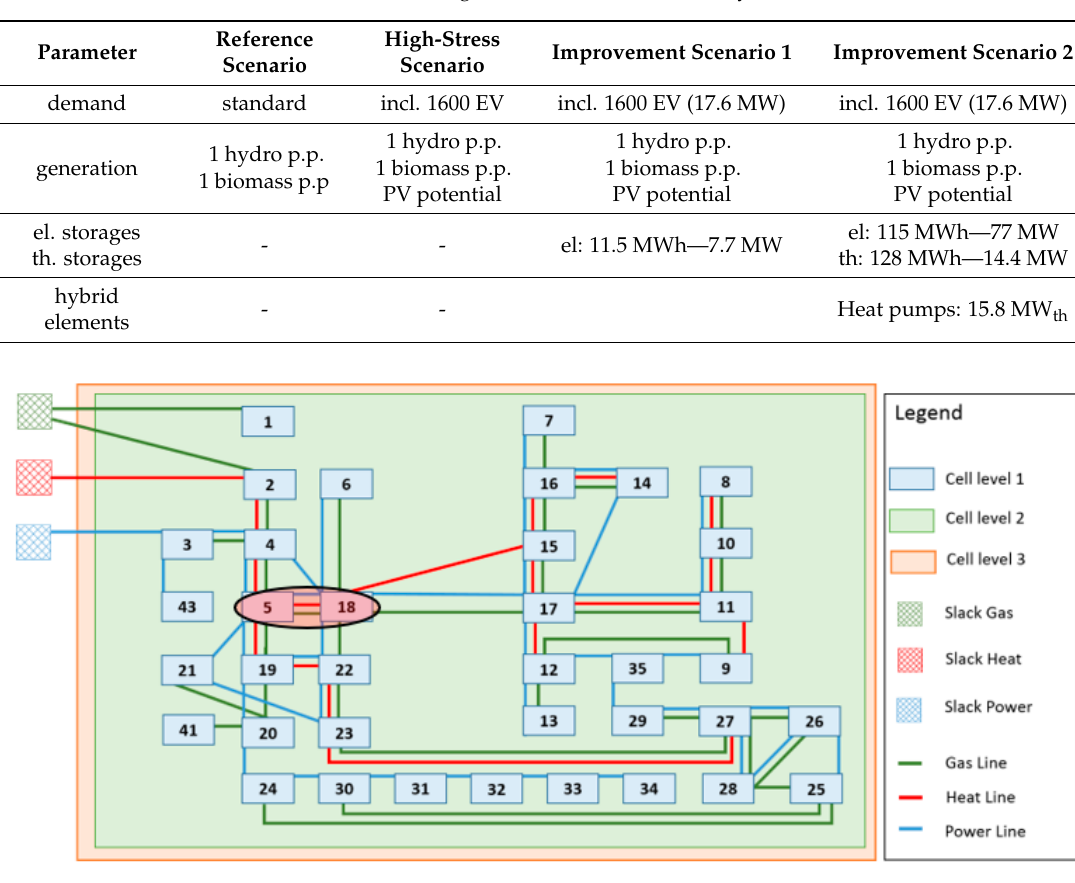
Figure 6. Topology of case study 1.